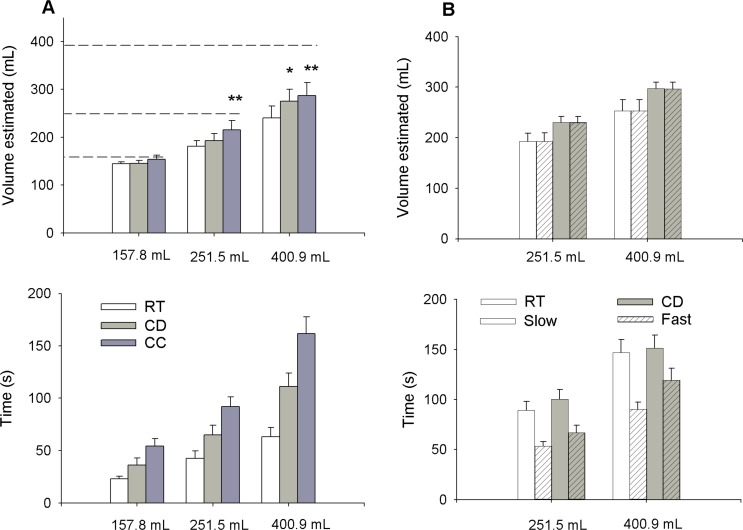
Estimated volume of beverages ingested when blind to the volume.Participants were asked to estimate how much they just ingested after drinking an experimental beverage presented in a lidded and opaque cup, through a straw without touching the cup. Legends and dashed lines correspond to actual volumes of the samples. Each condition was tested in triplicate. (A), Three beverages were tested: room temperature water (RT), cold water (CD) and cold carbonated water (CC). Upper panel displays ingested volumes estimated by participants and lower panel shows the time of completion to drink the whole sample. Data are represented as mean +/- SEM * indicates statistical significance at p<0.05 vs RT. (B), Participants did the same task with RT and cold water but at a forced rate (slow (10 bpm) or fast (20 bpm)). Upper panel displays ingested volumes estimated by participants and lower panel shows the time recorded to finish drinking the whole sample. Data are represented as mean +/- SEM. (n = 10 participants).